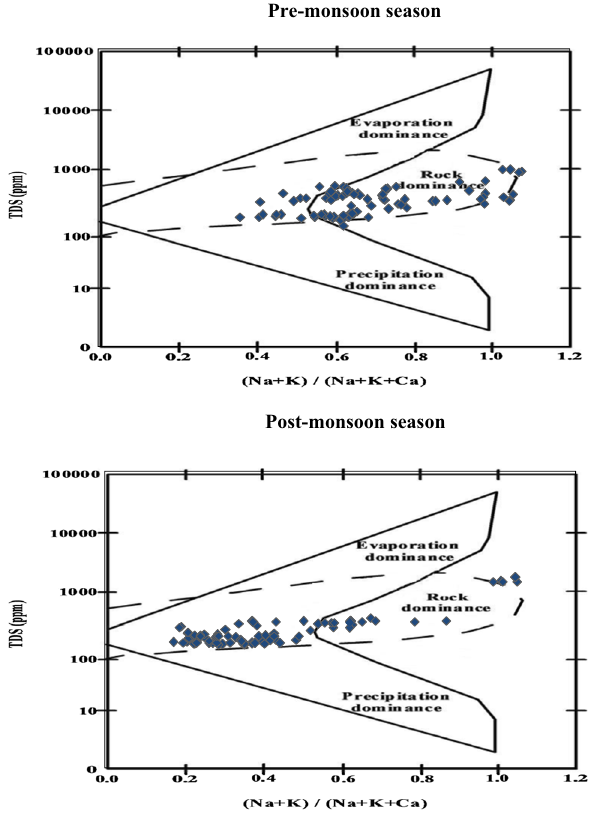
Fig. 4 Major natural processes controlling Sutlej river water chemis- try ( Adapted from Gibbs